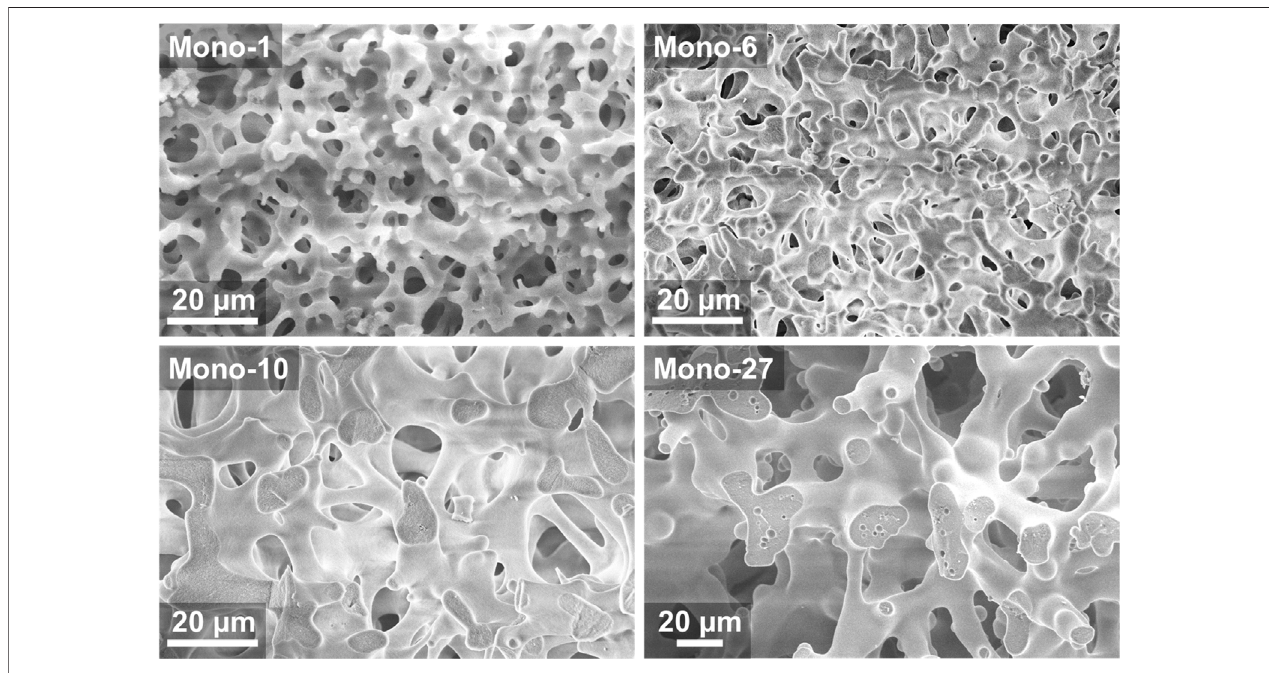
FIGURE 3 | SEM images of HSM samples (Mono-1 through Mono-27) exhibiting the homogeneous arrangement and size of macropores and the growth and thickness of the silica skeleton inside the overall structure.